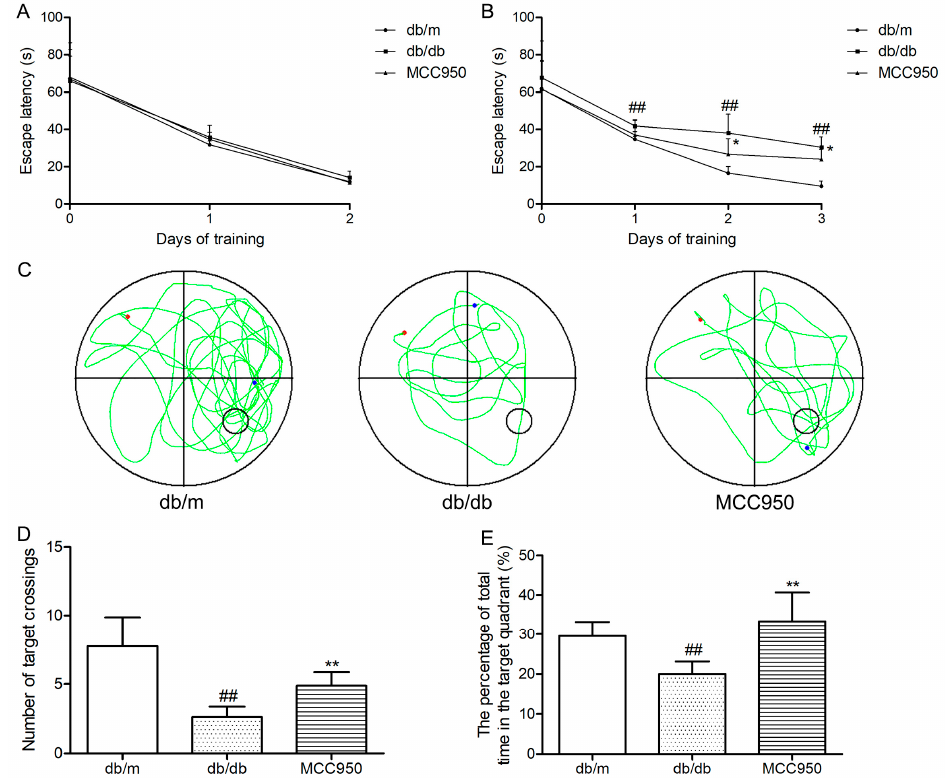
Figure 4. Effects of MCC950 on cognitive dysfunction in db/db mice. In the Morris water maze (MWM) test, day 0 means performance on the first trial, and subsequent points indicate the average of all daily trials. ( A ) Escape latency of the two-day visible-platform test;( B ) Escape latency of the three-day hidden-platform test; ( C ) Representative swim paths during the probe test (the red dot represents the starting point, and the blue dot represents the end point); ( D ) Number of target crossings in the probe trial; ( E ) Percentage of total time spent in target quadrant in the probe trial. All data are represented as mean ± SD for eight mice in each group. ## p < 0.01, compared with the db/m-group; ** p < 0.01, * p < 0.05, compared with the db/db-group.